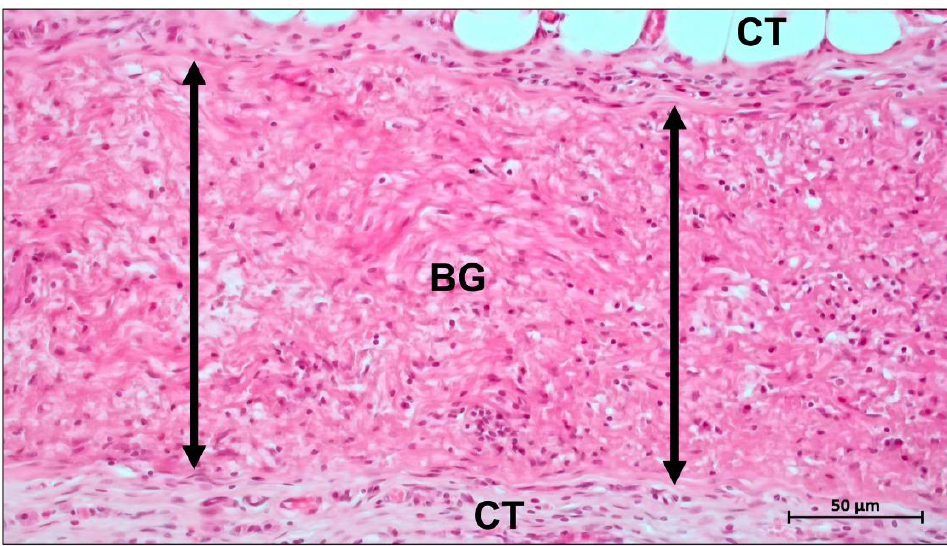
Figure 2. Representative histological image showing the tissue reaction and integration behavior of the Bio-Gide membrane (GB, double arrows) within the subcutaneous connective tissue (CT) at day 60 post implantationem (HE staining, 200× magnification, scalebar = 50 µm). A similar structural design can also be achieved by crosslinking. For example, He et al. showed that the large pore size (240 – 310 μm) oxidized sodium alginate (OSA)